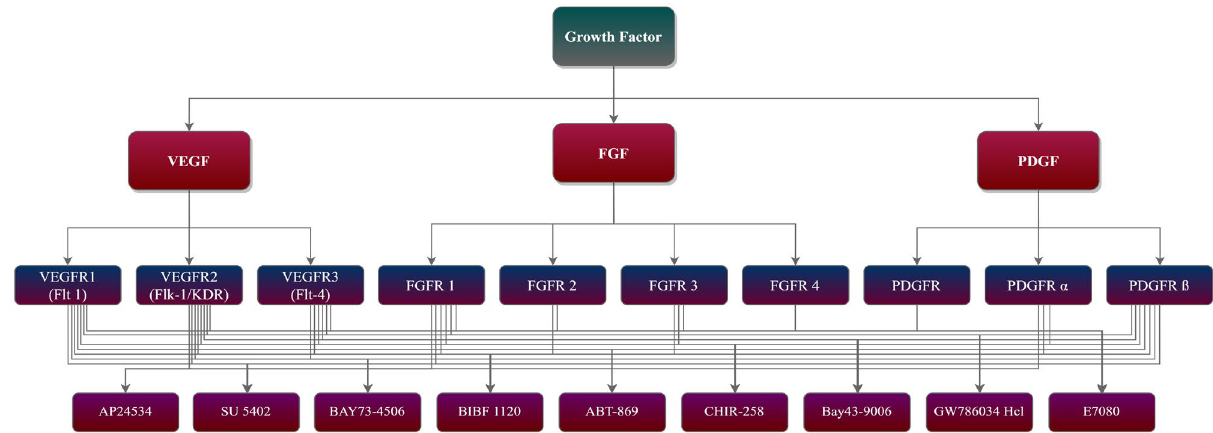
Figure 2. Hierarchical Representation of Angiogenesis GF along with Receptors and